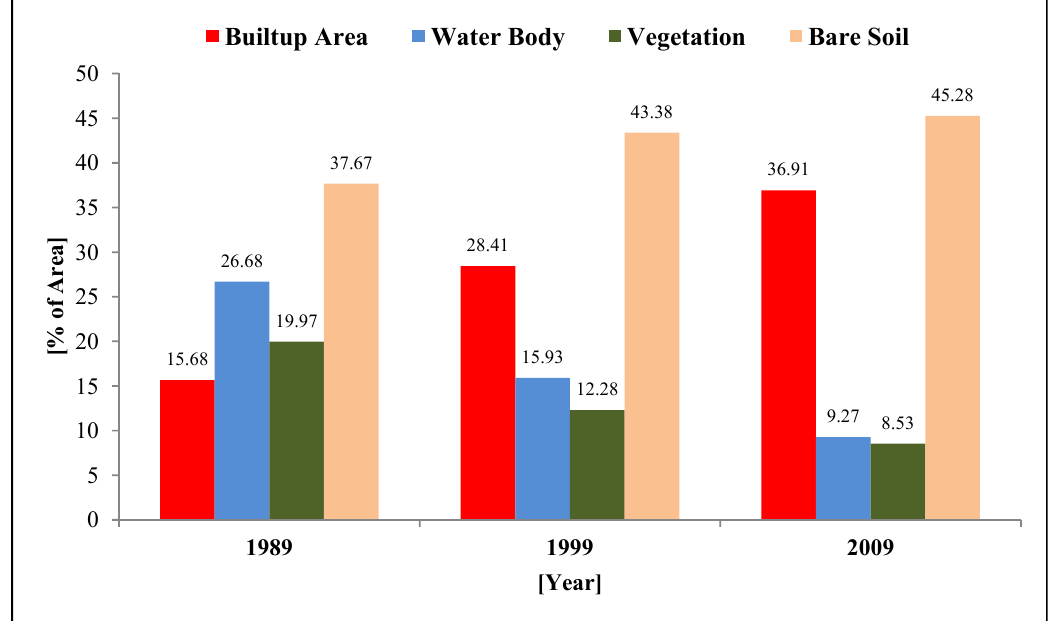
Figure 6. Percentages of presence of land cover types in DMP area.